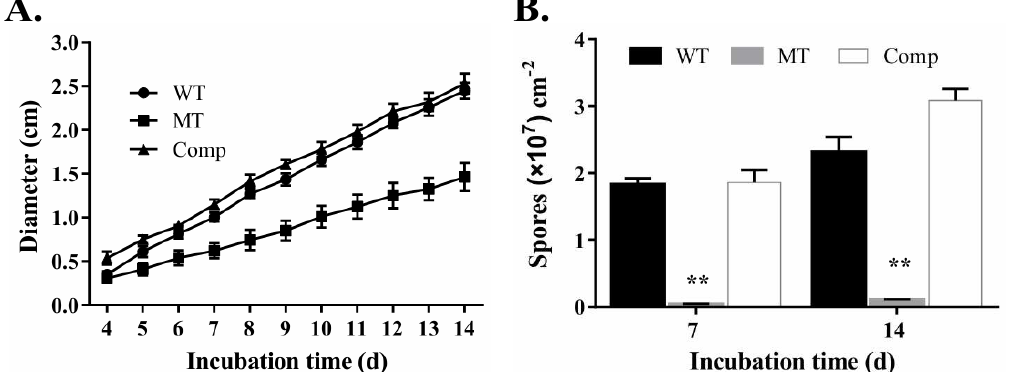
Figure 5. Assays for vegetative growth and conidial production under continuous heat-stress conditions. (A) Vegetative growth of di ff erent strains during the 4–14-day cultivation period on PDA plates under heat stress (35 ◦ C), and the growth rates of the ∆ MrUBI4 strain decreased significantly (Tukey’s test, p < 0.01) after 4 days post-inoculation. (B) Conidial production of di ff erent strains cultured on PDA plates for 7 and 14 days under heat stress (35 ◦ C). **, p < 0.01. WT: wild-type strain, MT: ∆ MrUBI4 strain, Comp: complementary